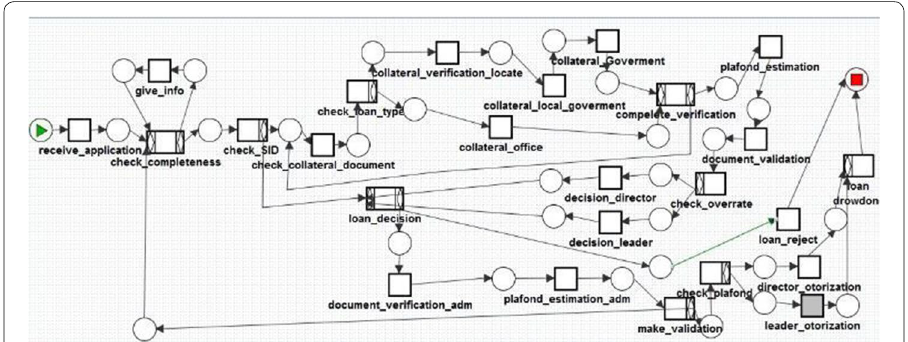
Fig. 1 Effects of selecting different switching under dynamic